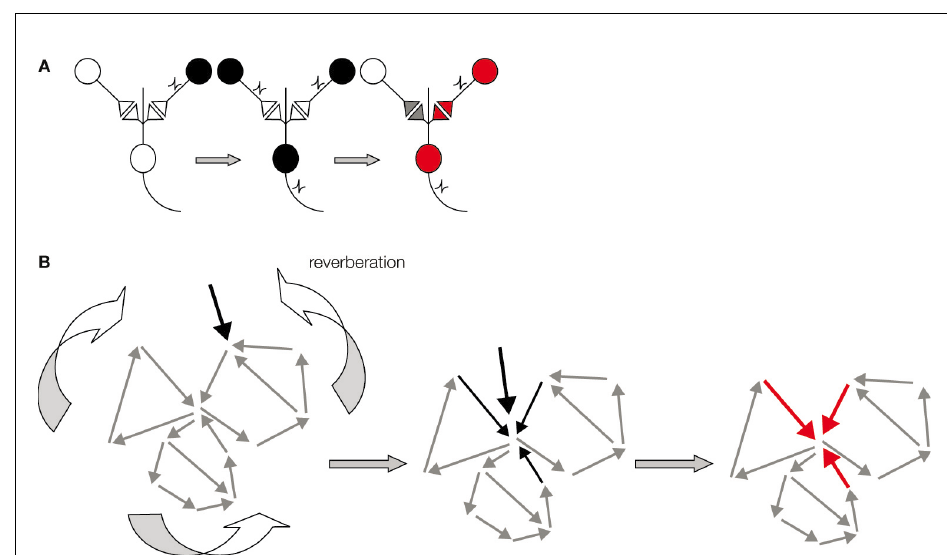
Figure 1 | Schematic representations of two Hebbian postulates underlying memory formation in the brain. (A) Schematics of Hebbian associative plasticity. Cells that fi re together wire together. From left to right: Presynaptic cell (black) does not activate post synaptic cell when fi ring on own. When two presynaptic cells fi re simultaneously post synaptic cell fi res action potential. This coincident fi ring of two presynaptic cells leads to synaptic strengthening. Now when the same presynaptic cell fi re on own (red) it now activates the post synaptic cell. (B) Schematic of the second Hebbian postulate: reverberating ensemble of neurons. From left to right: The network may reverberate when a sensory signal (black arrow) enters at one node in an interconnected neurons ensemble (grey small arrows). This signal will remain active in the ensemble by moving from neuron to neuron within the network. The path of transmission will vary depending upon neurons’ history of activity, current synaptic strengths and other sensory signals entering the network. Thus, reverberation may follow different paths at each iteration. This reverberant activity can become coincident with new neural signals (middle, black arrows), thereby facilitating ‘Hebbian postulate one’ plasticity at some synapses in the network (in